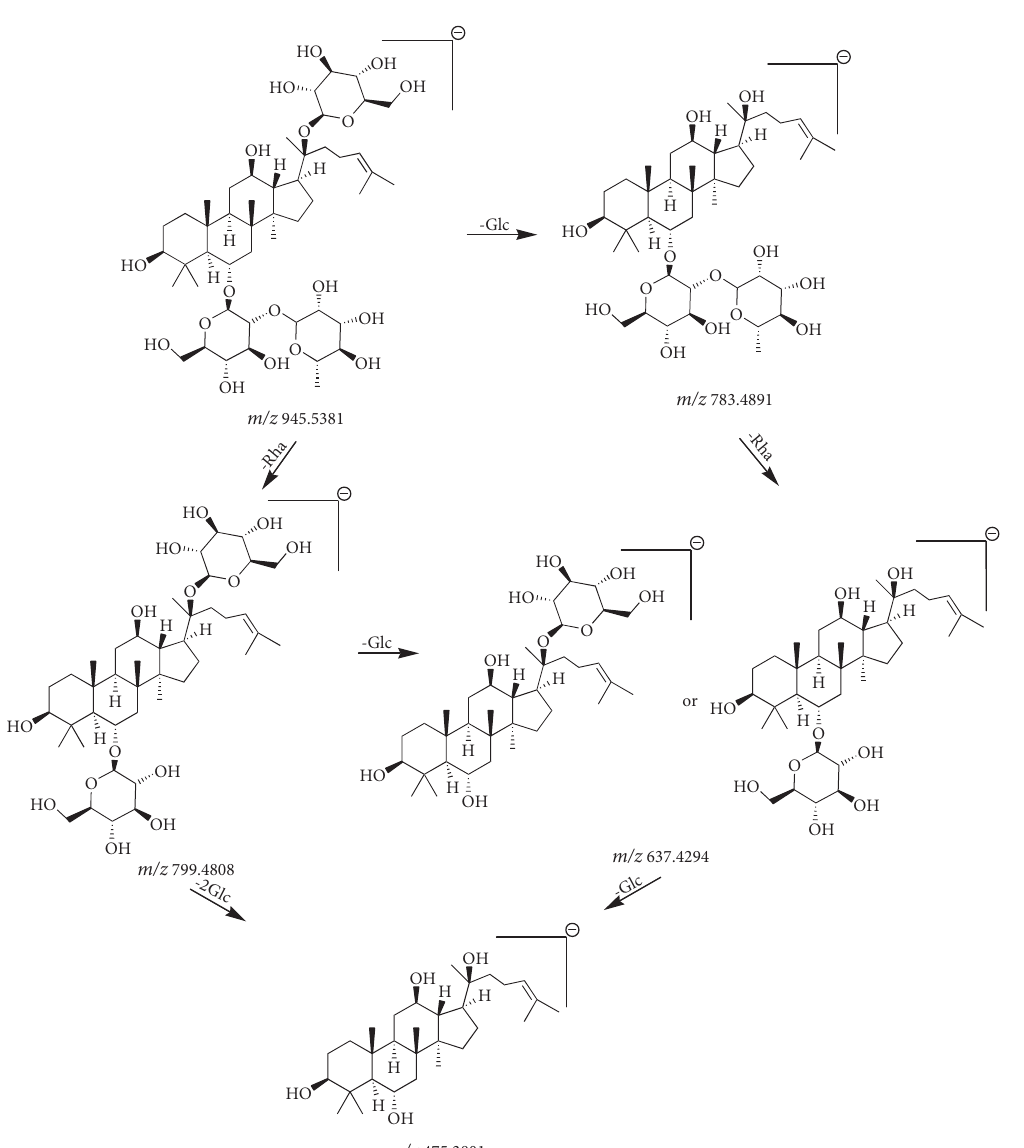
Figure 7: The fragmentation pathway of ginsenoside